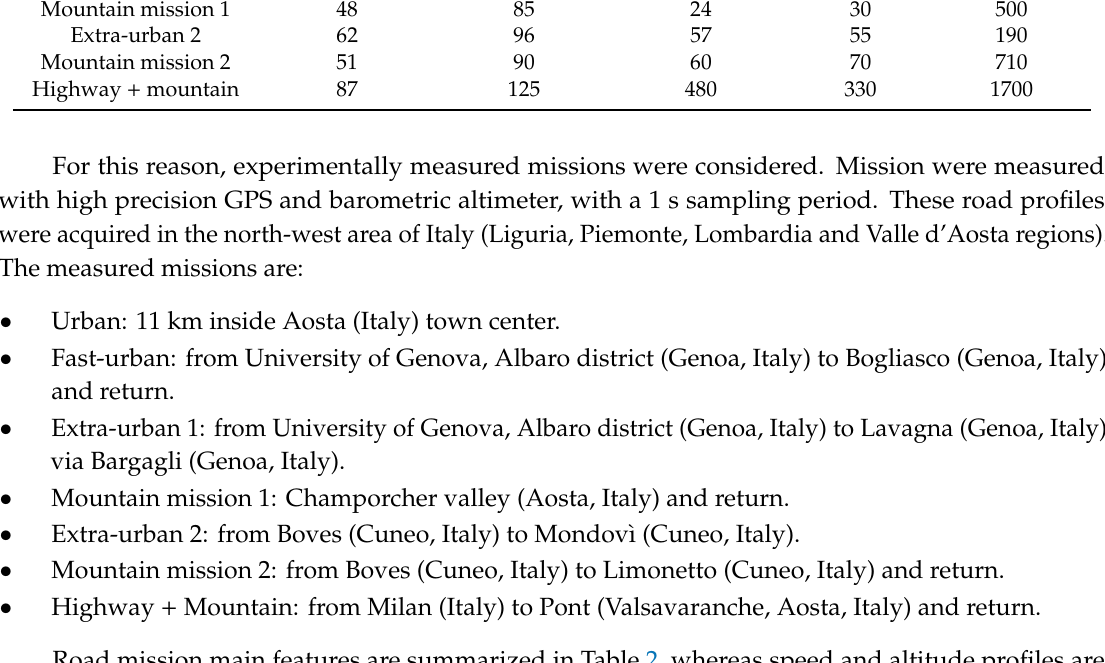
Figure 5. Urban. Figure 5. Urban.